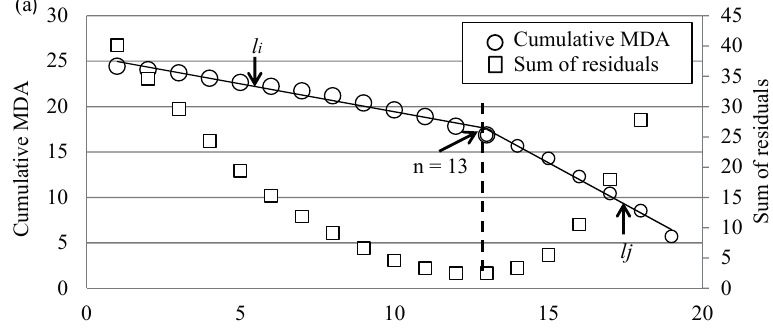
Figure 3. Cumulative MDA (mean decrease accuracy) values for geometric classifiers ( a ) and cumulative MDA values for vertical profile classifiers ( b ); the residual sum of squares residual for fitting two linear lines through the cumulative MDA curve; dotted line shows where the residual sum of square minimizes. Solid lines represent l i and l j at optimized J